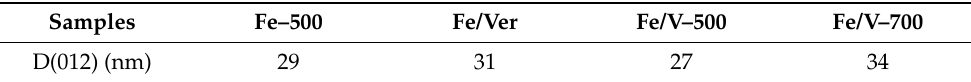
Table 3. The mean coherent crystallite size D (012) of hematite in α -Fe 2 O 3 nanoparticles sole and in α -Fe 2 O 3 /vermiculite